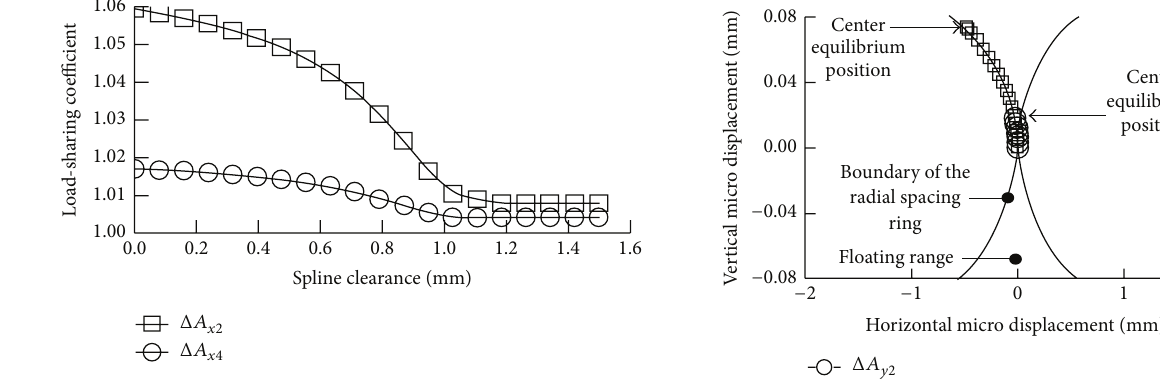
Figure 16: The load-sharing coefficient changed with spline clear- ance.